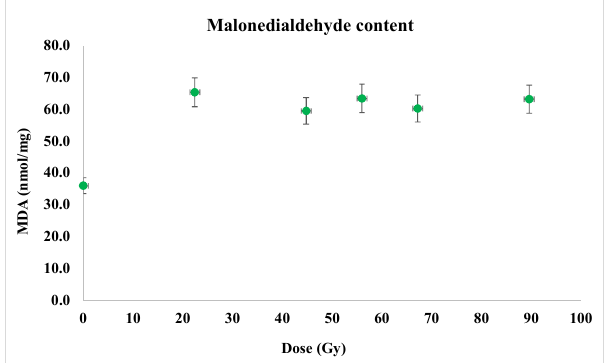
Figure 11. The content of malondialdehyde in the samples corresponding to the proton irradiation at the Bragg peak . Considerable increase in MDA in the samples corresponding to irradiated seeds was emphasized. For each experimental variant, three repetitions of the MDA content assay were carried out.